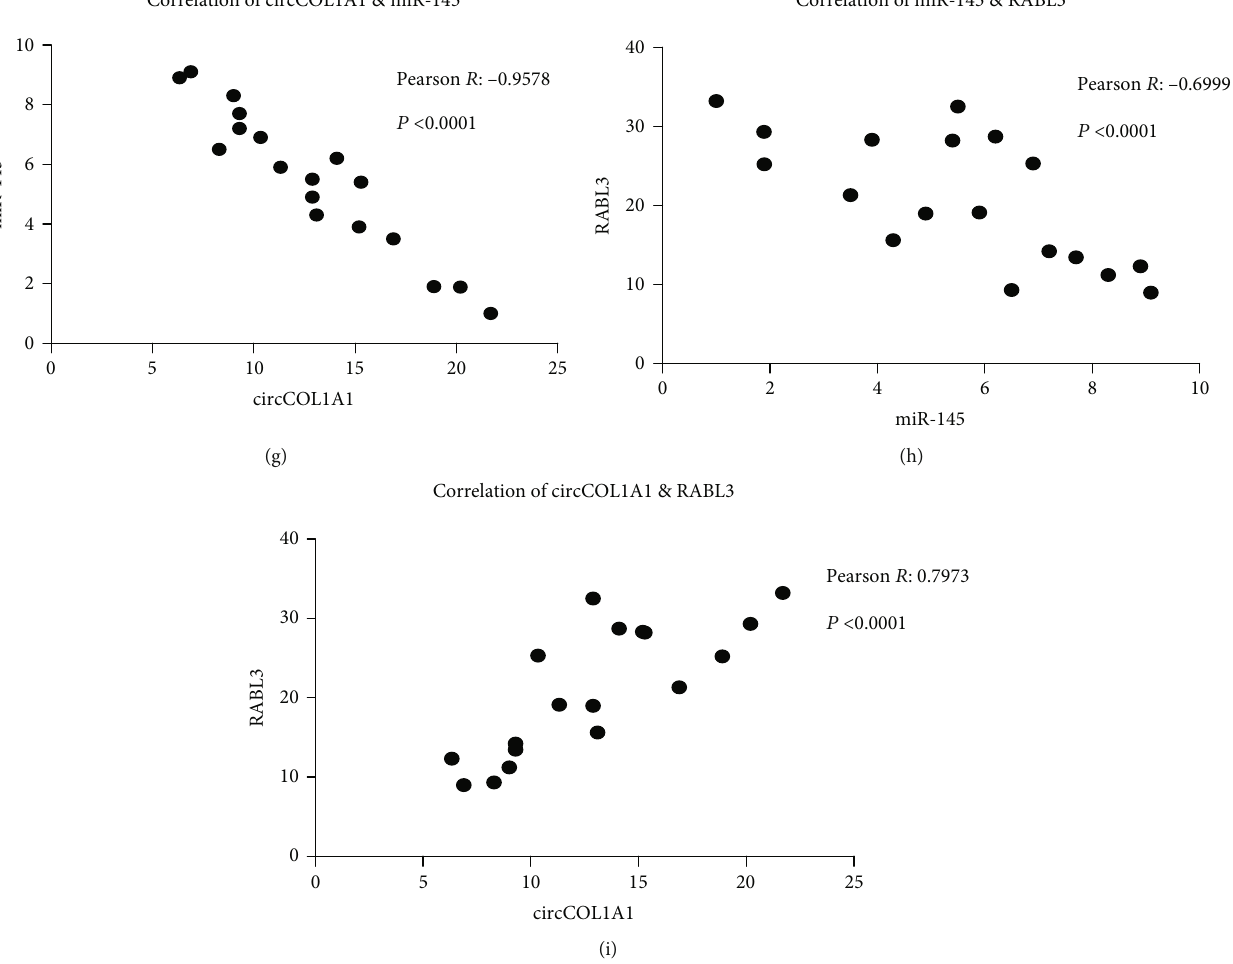
Figure 7: circCOL1A/miR-145/RABL3 axis in vivo. (a) 2 × 10 6 AGS/NC and AGS/si-circCOL1A1 cells were subcutaneously injected into the ventral fl anks of 5-week-old female nude mice. The tumors were measured every three days when the tumor reached 3mm × 3mm . At the 32th day, all mice were sacri fi ced, and tumors were excised and photographed. (b) The tumor volumes were calculated according to the formula: V = length × width 2 /2 . The data indicated mean with SD of 6 tumors. (c) The weight of tumors of six tumors at the 32th day. (d) The expression of miR-145 and RABL3 in tumors of nude mice. (e) AGS was cocultured with macrophages, and fl ow cytometry assays were carried out to detect the percentage of M1 (CD86+) and M2 (CD206+). (f) MKN-45 was cocultured with macrophages, and fl ow cytometry assays were carried out to detect the percentage of M1 (CD86+) and M2 (CD206+). (g) The correlation between circCOL1A1 and miR-145. (h) The correlation between miR-145 and RABL3. (i) The correlation between circCOL1A1 and